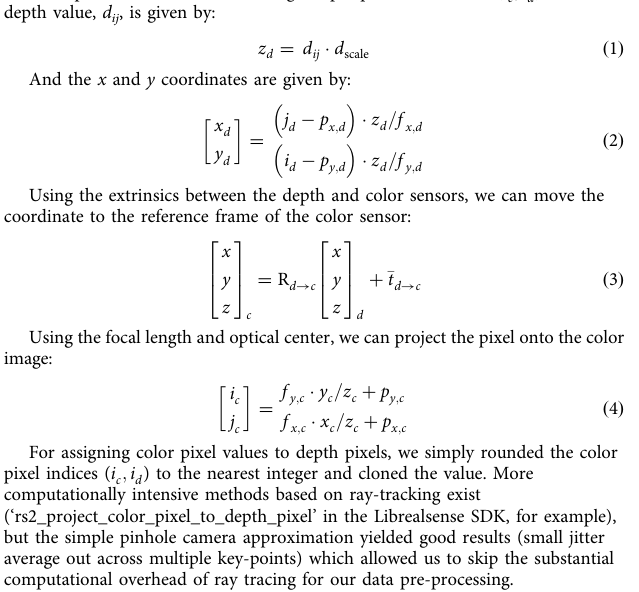
Figure 3. The ‘ fake laser dot pattern ’ was generated using the ‘ snow fl akes ’ generator in the imgaug routines for generating weather effects, tuned to look — by eye — to a